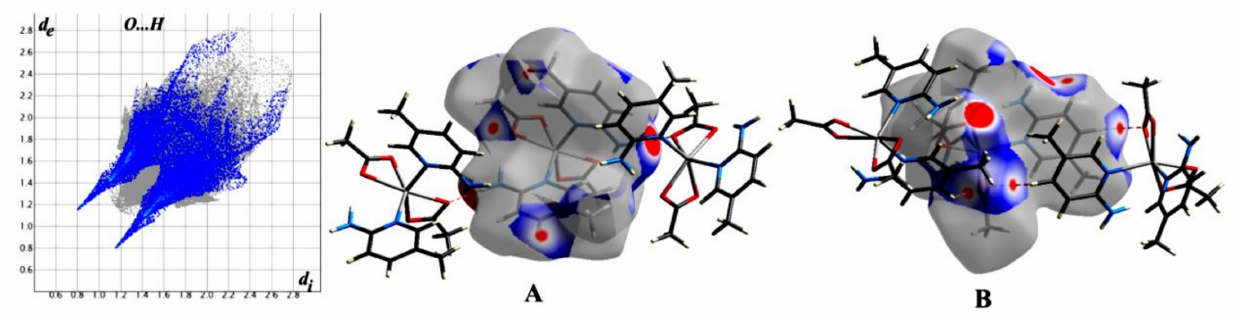
Figure 11. The FP plot and d norm maps showing the different N-H ··· O ( A ) and C-H ··· O ( B ) interac- tions in complex 3